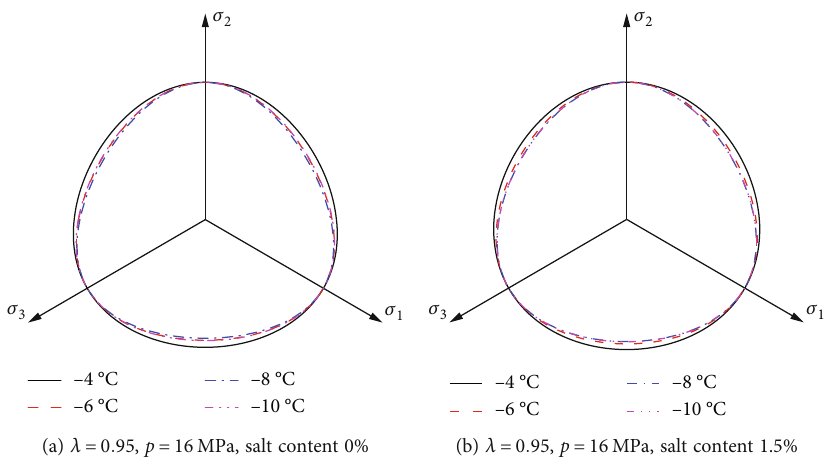
Figure 9: Shape curves in deviatoric plane at di ff erent values of